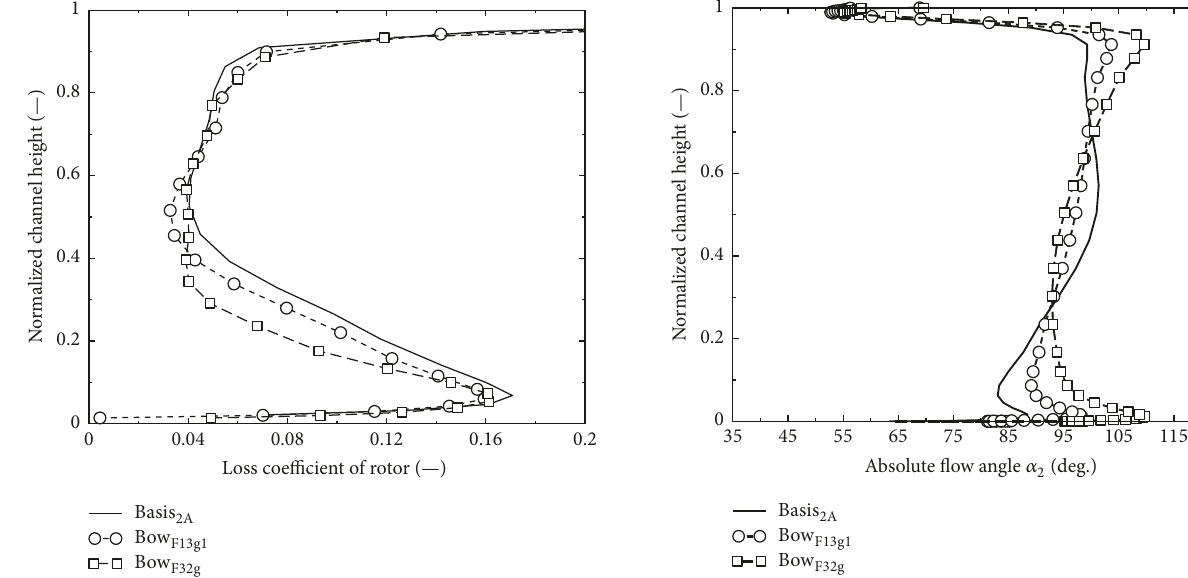
Figure 14: Circumference averaged loss coefficient of the rotor over the channel height.